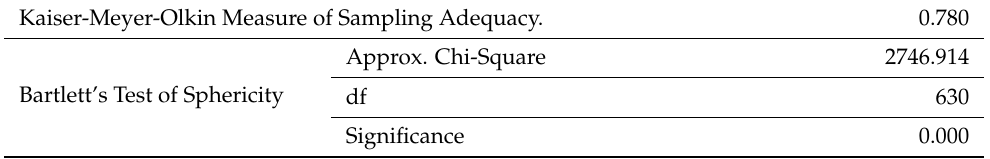
Table 3. Kaiser-Meyer-Olkin and Bartlett’s